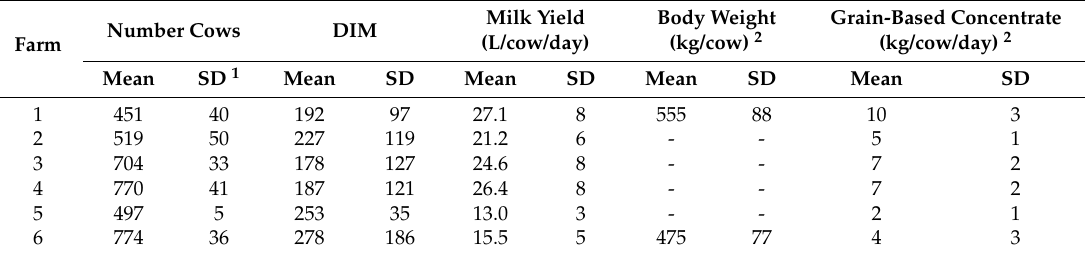
Table 1. The number of cows, days in milk (DIM), mean weekly milk yield (L/cow/day), body weight (kg/cow), and grain-based concentrate offered (kg/cow/day) for six farms at the start of experiment 1. Number Cows Farm